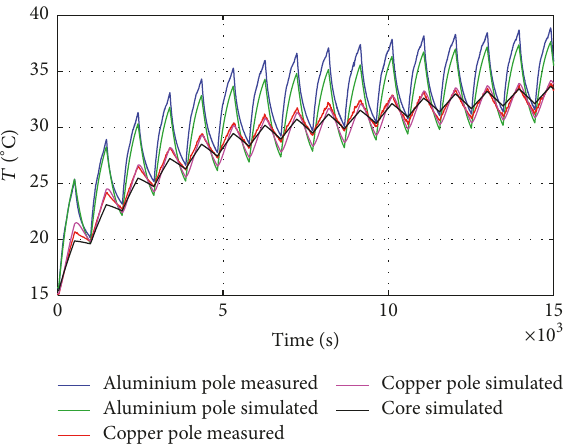
Figure 8: Model output and system output comparison for 1st set of measurements.